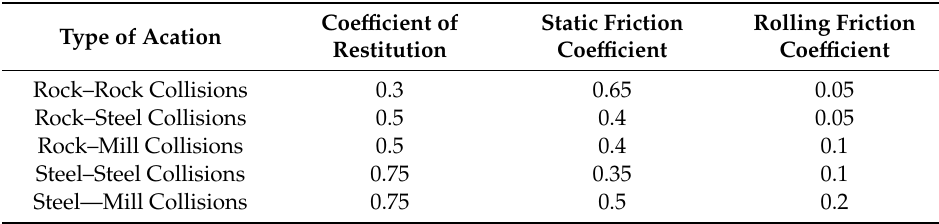
Table 2. Collision parameters.